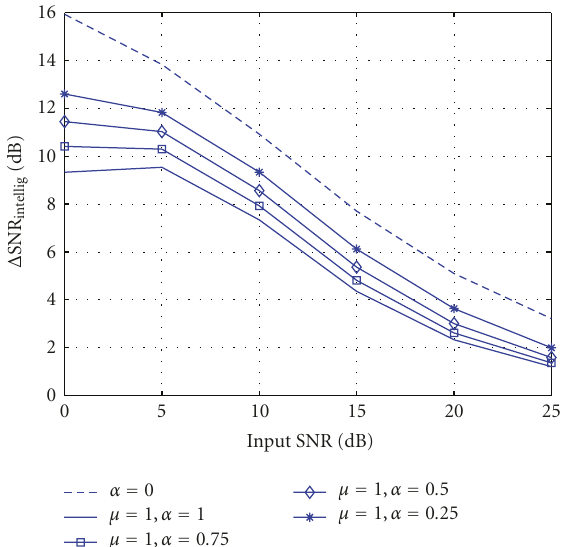
Figure 12: SNR improvement for SDW-MWF SPP ( α = 0) and